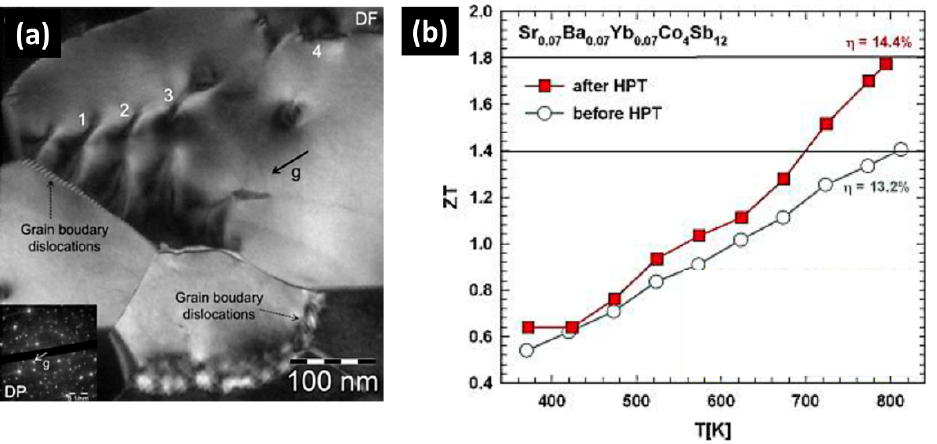
Figure 13. ( a ) Energy-filtered high-magnification dark-field TEM images of Sr 0.07 Ba 0.07 Yb 0.07 Co 4 Sb 12 (cross section); Positions 1, 2, 3 and 4 represent some dislocation structures. ( b ) temperature-dependent ZT of Sr 0.07 Ba 0.07 Yb 0.07 Co 4 Sb 12 sample before HPT and after HPT [88]. Insert in ( a ): energy-filtered selected area diffraction pattern.